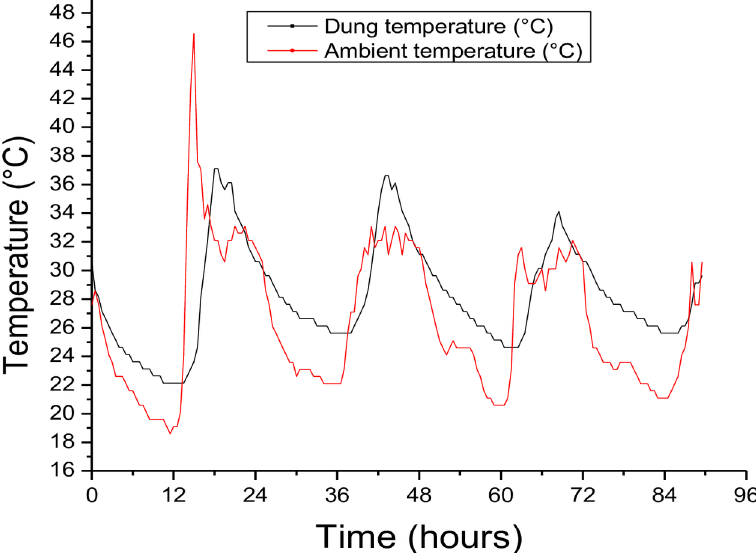
Fig 4. Differences in microclimate temperature records between ambient and ‘inside-dung’ during a one-week dung pat decomposition period in Khumaga village. Temperature was recorded using i-Buttons (DS1923, Maxim, Sunnyvale, CA, USA) at 15 minutes sampling interval for 5 days (January 19–23 2017). One i-Button was immersed in the middle of a freshly dropped cow dung pat, while the other one was placed in a shaded environment, ~1 m above the